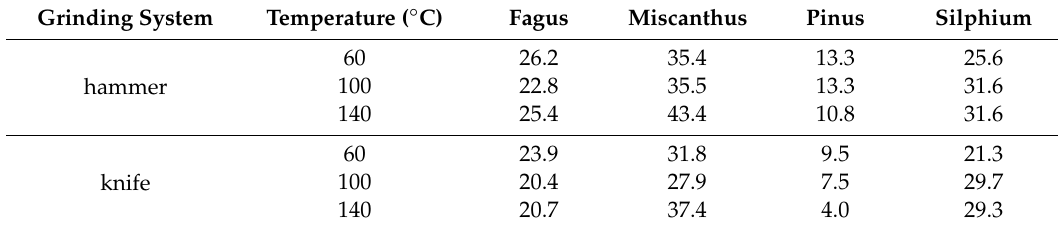
Table 4. Biomass grindability defined as relative change of ϕ